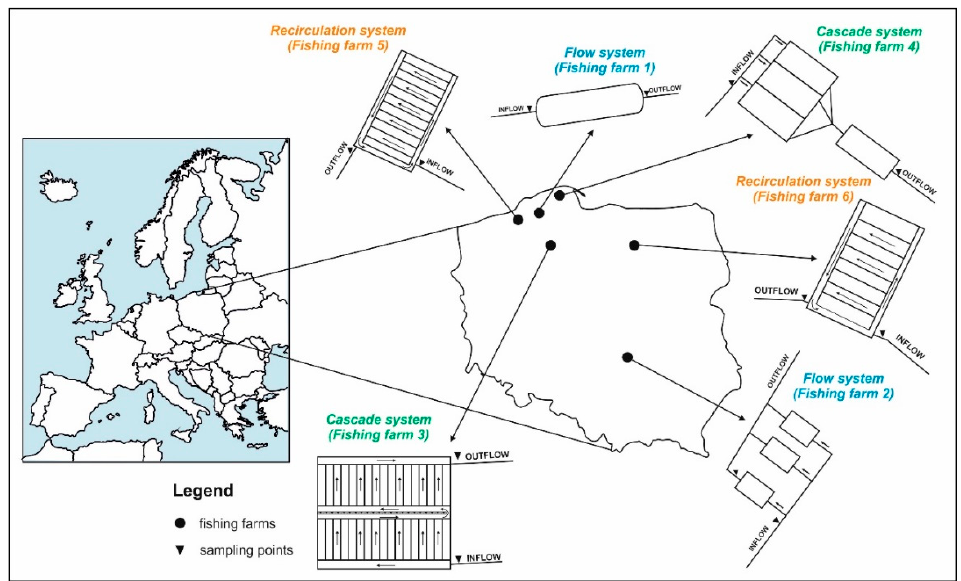
Figure 1. Location of fish farms.